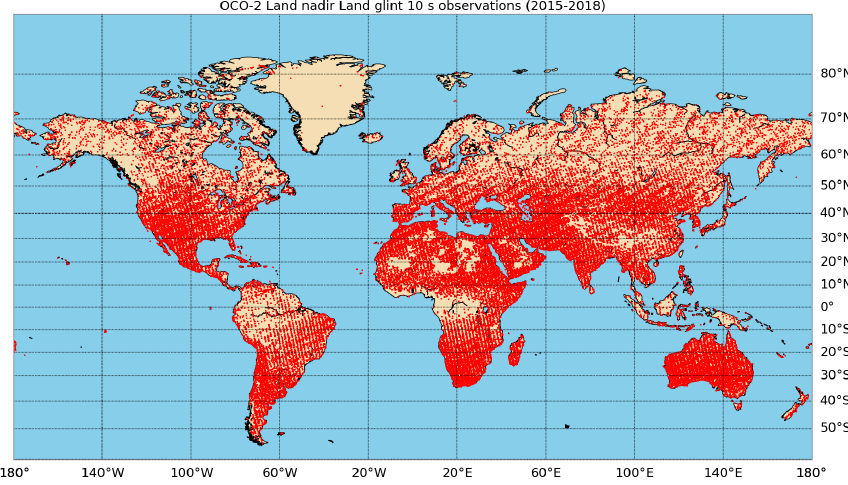
Figure A1. Locations of OCO-2 land nadir and land glint 10s retrievals for the period of study (2015 through